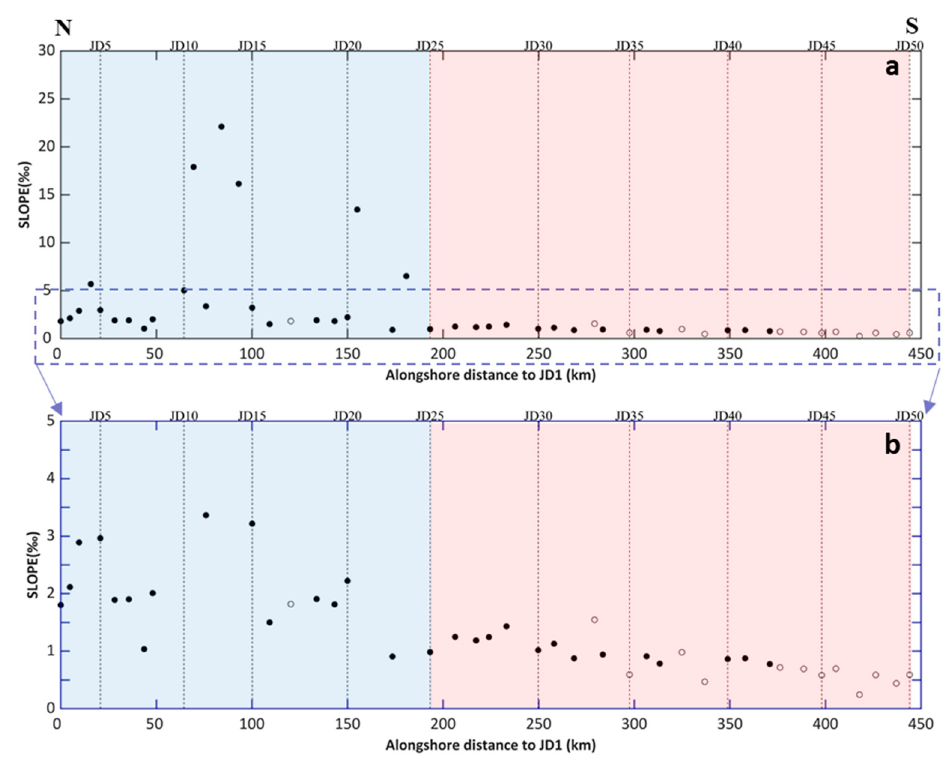
Figure 7. Calculated intertidal flat slopes of the 50 profiles based on Baseline Method ( b ) is a zoom in of the 0~5‰ part on ( a ). Black dots represent profiles not affected by dykes or large tidal creeks, and black circles are associated with profiles which are affected.